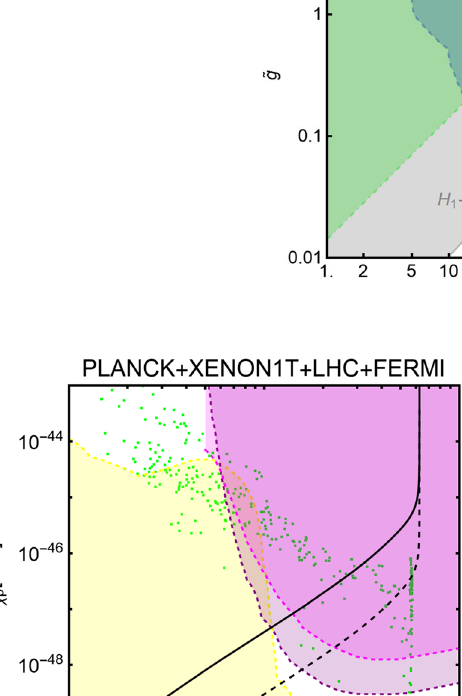
Fig. 12 Summary of constraints for benchmark points of the dark U(1) model. The red contours correspond to the correct relic density, the blue region is excluded by constraints from DM direct detection by XENON1T, the orange/yellow regions correspond to exclusions from FERMI/CMB and the gray region corresponds to the bounds from the Higgs invisible branching fraction. Finally, the green region is excluded by the constraints on the scalar self-couplings from perturbative unitarity